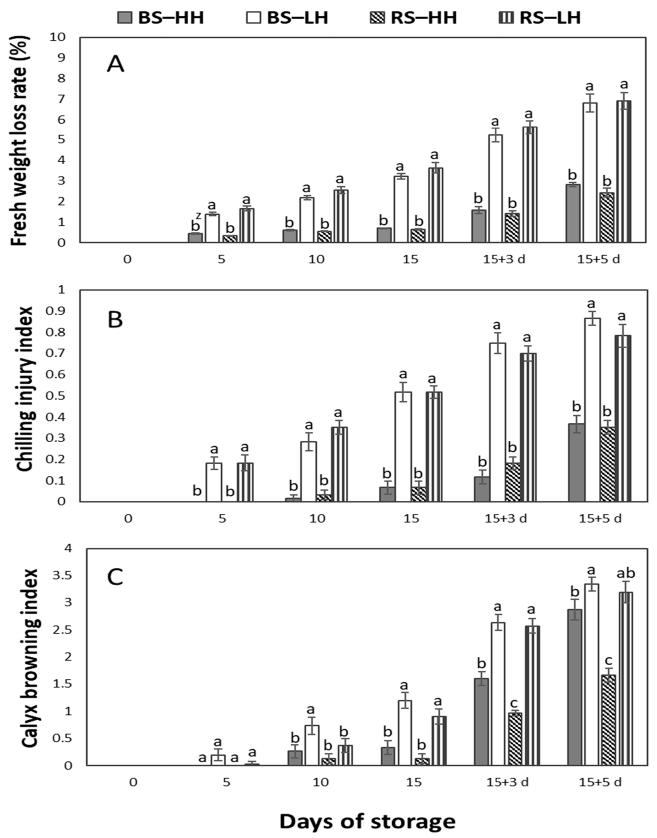
Figure 1. High and low RH effects on sweet peppers’ weight loss ( A ), chilling injury (CI) index ( B ), and calyx browning index ( C ) during 15 days of cold storage at 5 ◦ C and 5 days at ambient conditions. HH means fruit kept in a humidified refrigerator, and LH means fruit kept in a regular refrigerator, while BS (breaker stage) and RS (red-ripe) represent maturity stages. Vertical bars represent ± SE of the mean ( n = 5). Z Different letters represent significant differences among treatments for each sampling day using Tukey’s multiple comparison test at p ˂ 0.05. Note: 15 + 3 d means the third day in ambient conditions, and 15 + 5 d means the fifth day in ambient conditions.